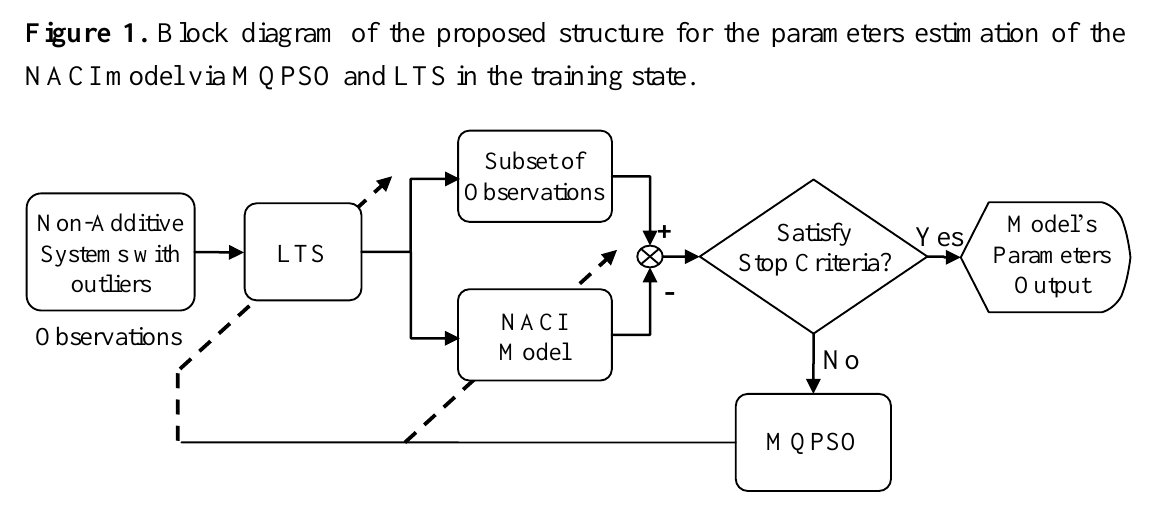
Figure 2. Block diagram of the proposed structure for information fusion